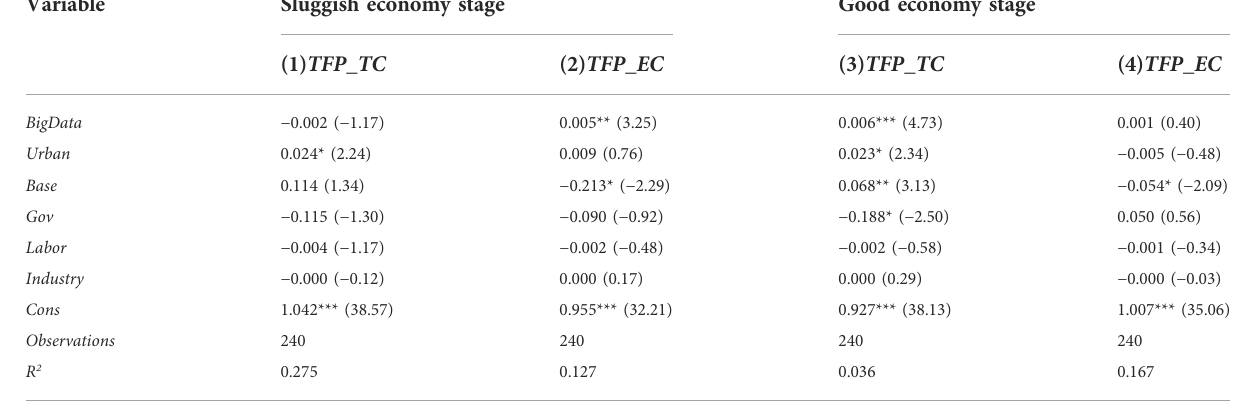
TABLE 8 Empirical results of time